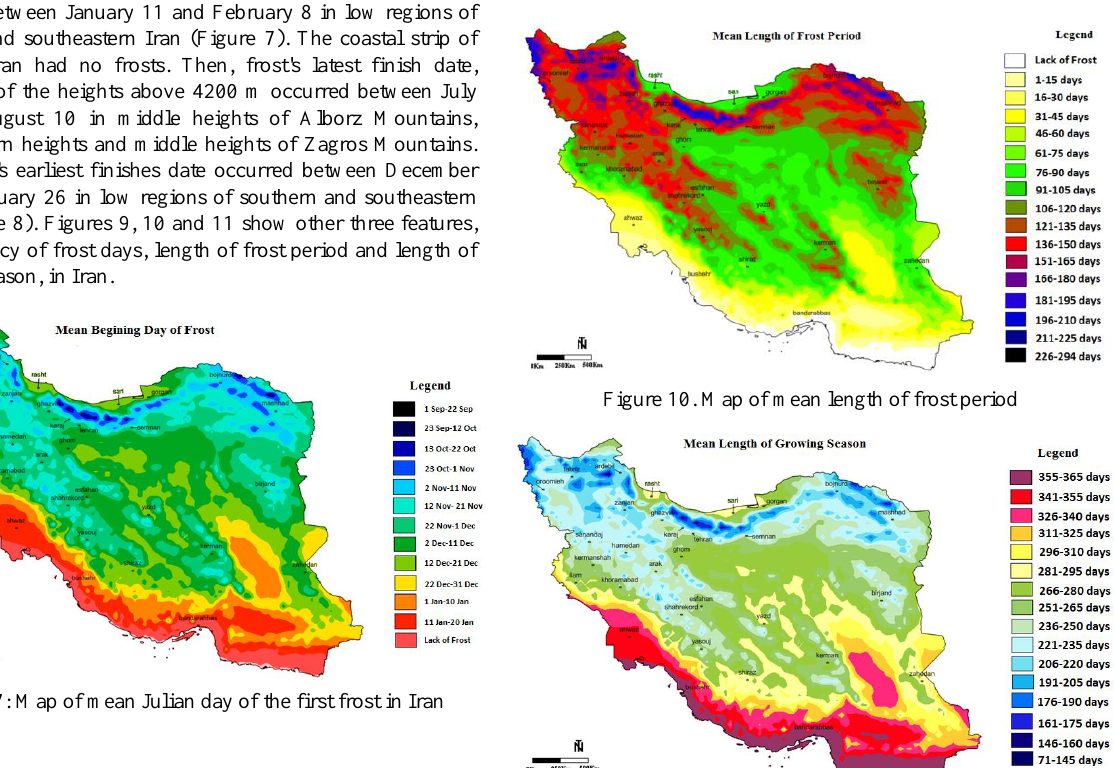
Figure 11: Map of man length of growing